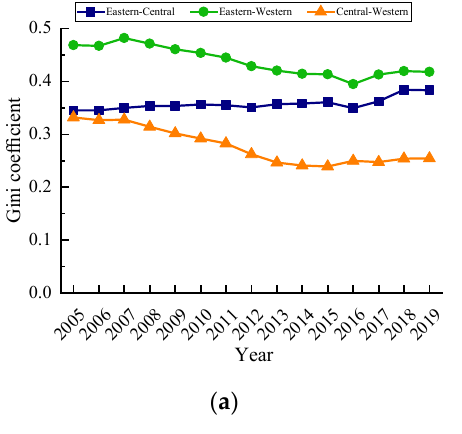
Figure 4. Int er -regional Gini coefficient of carbon emissions of urban production energy Figure 4. Inter-regional Gini coefficient of carbon emissions of urban production energy consumption consumption from 2005 to 2019. ( a ) Carbon emission quantity. ( b ) Carbon emission intensity. from 2005 to 2019. ( a ) Carbon emission quantity. ( b ) Carbon emission